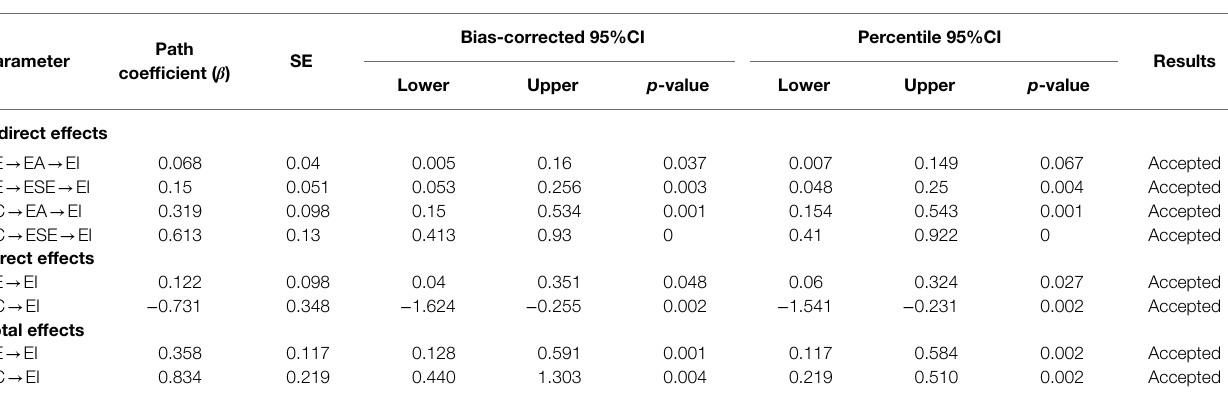
TABLE 7 | The mediating testing